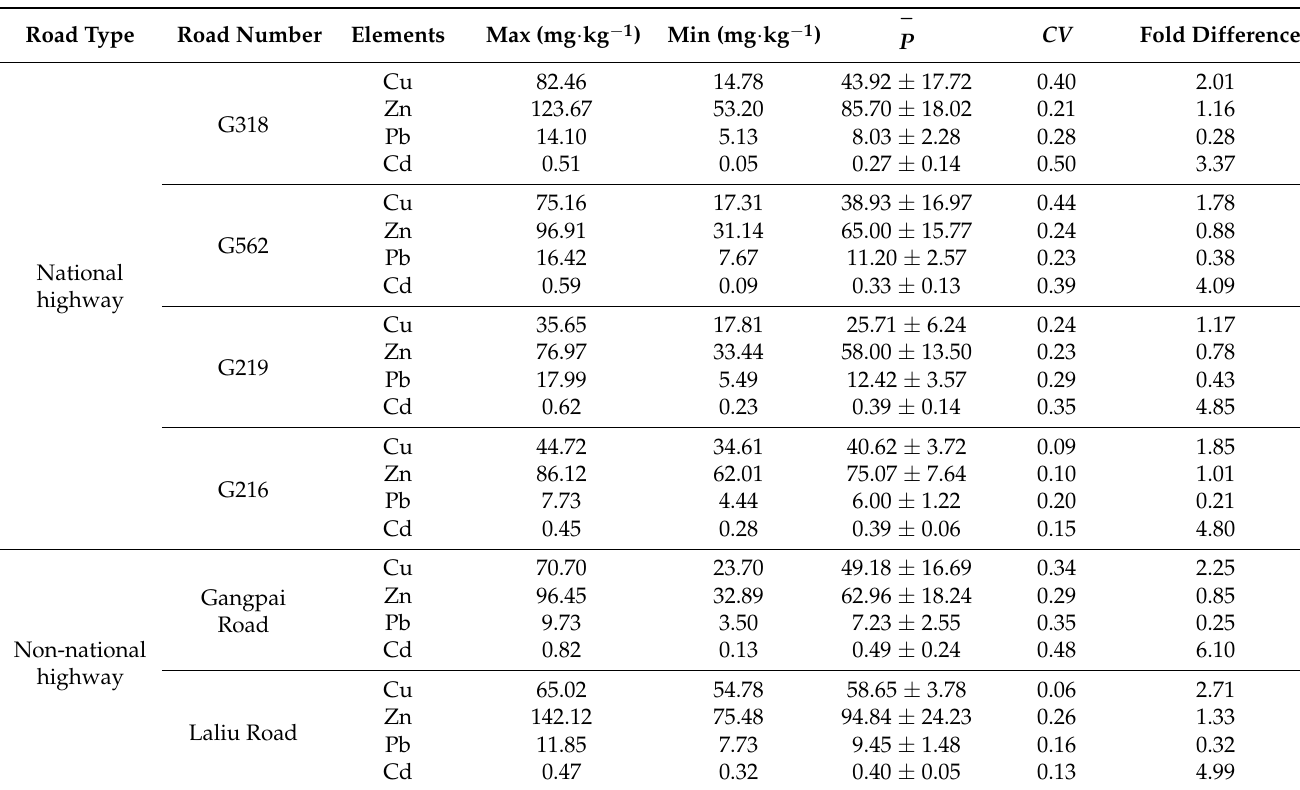
Table 5. Descriptive statistics of soil heavy metal concentrations (mg · kg − 1 ) and their distributions near different types of roads.